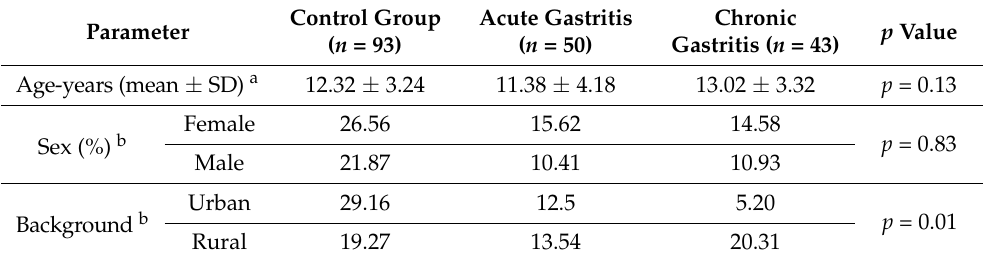
Table 3. Demographic characteristic comparison of controls versus subjects with acute gastritis and chronic gastritis.